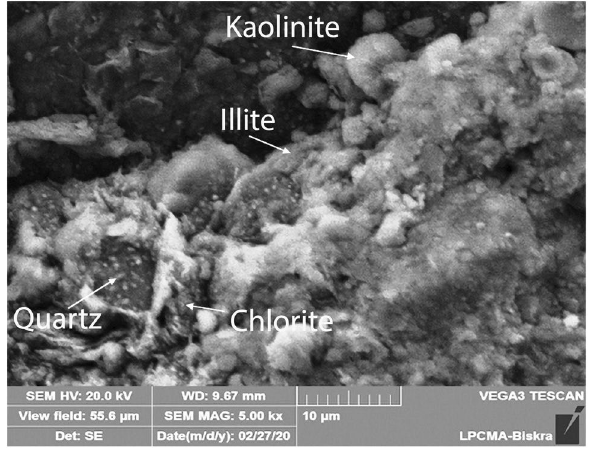
Fig.10 SEM photomicrographs (backscatter images) of sample T2